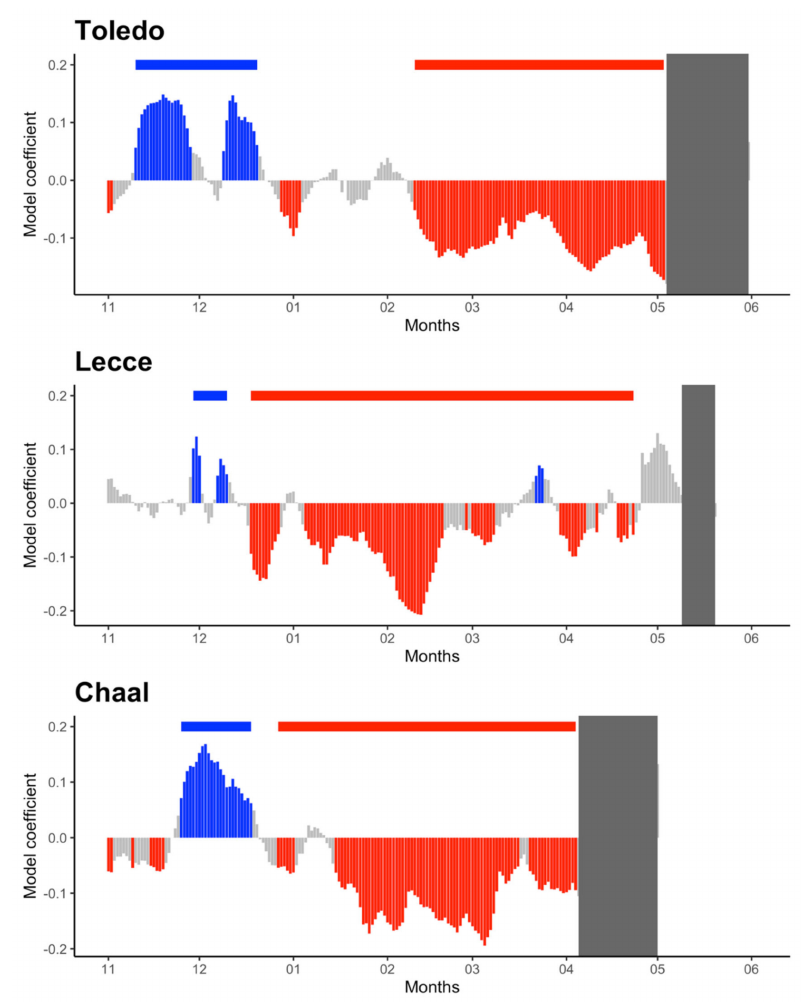
Figure4. Estimationofthechillingandheataccumulationperiodsaccordingtothethermalrequirements. The chilling periods are shown in blue and heat periods in red. Horizontal lines represent the proposed chilling period (blue) and heat period (red). The dark grey area represents the range (min–max) of the onset of flowering for the periods